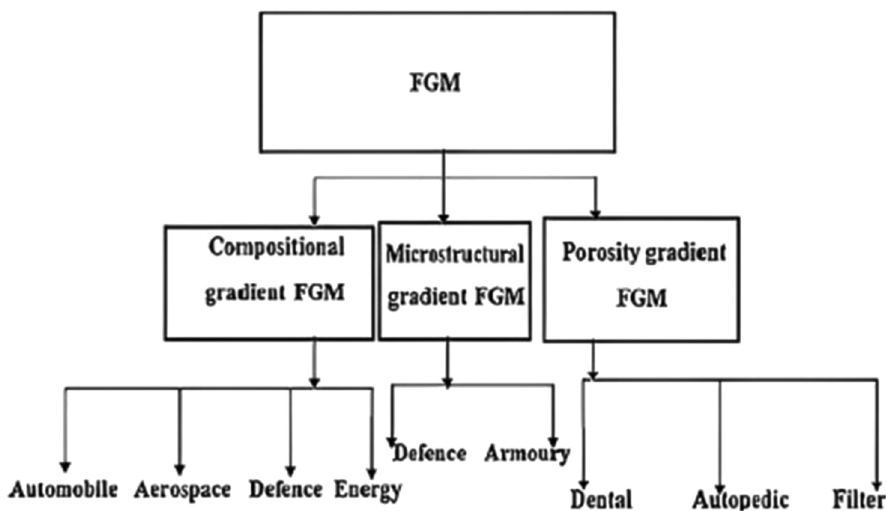
Figure 1: Application areas for each type of FGM [ 6 ] .